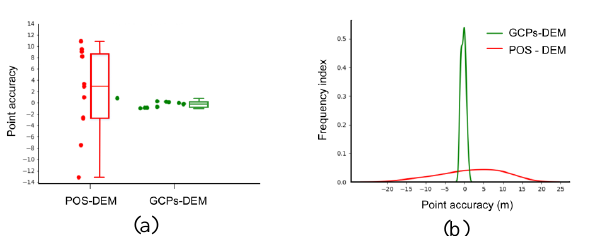
Figure 5. Accuracy of UAV-DEMs, georeferenced by POS and GCPs. (a) indicates the absolute error on the Z coordinate and (b) shows the error distribution